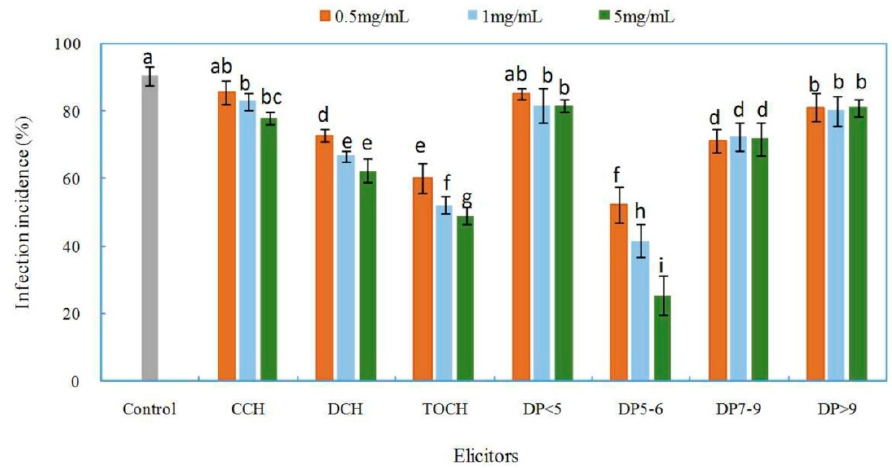
Figure 1. Effects of chitosan and oligochitosan elicitors from pathogen Fusarium sambucinum on infection of Zanthoxylum bungeanum stems. Different letters (a–i) indicate significant differences at a level of p < 0.05 of infection incidence among the treatments. CCH, crude chitosan; DCH, deacetyated chitosan; TOCH, total oligochitosan; DP, degree of polymerization.